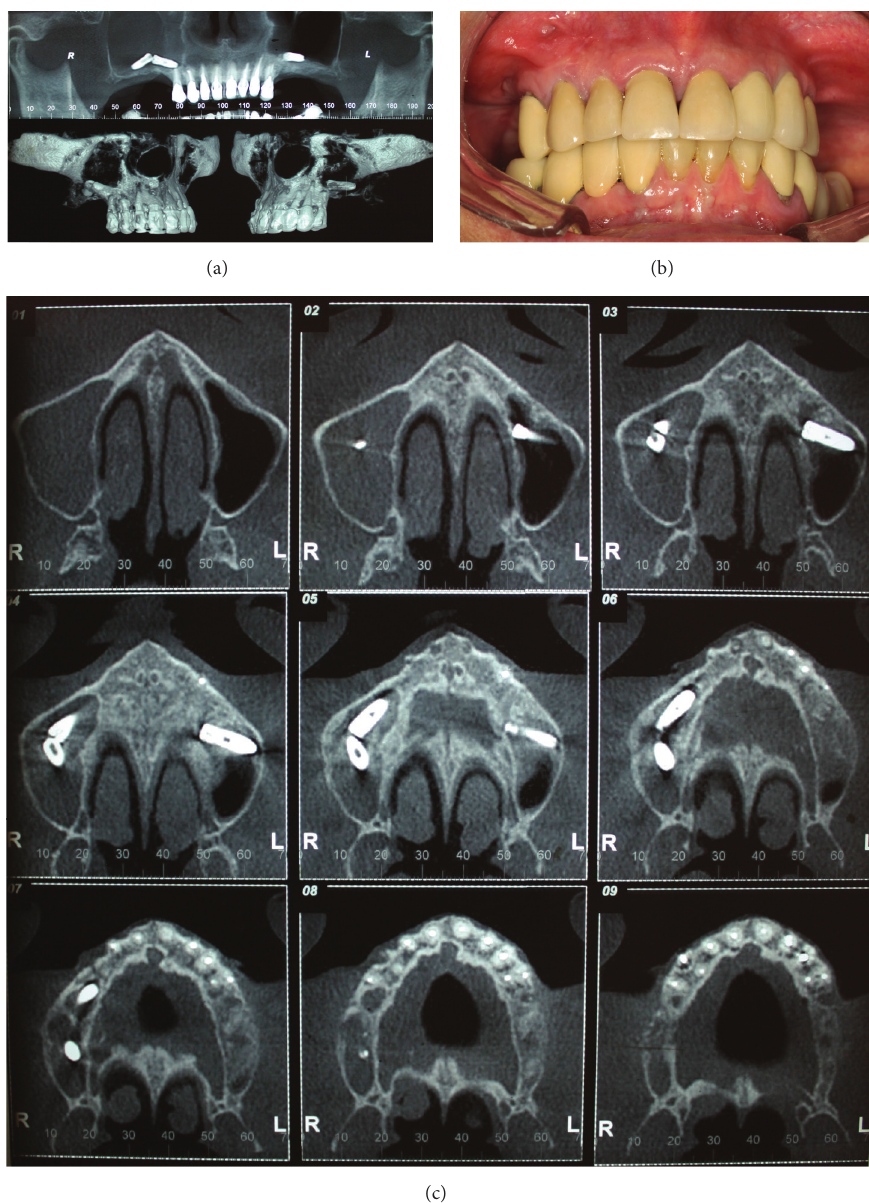
Figure 1: (a) A panoramic and a tridimensional reconstruction CT scan showing the implants displaced into the maxillary sinus cavity with a significant opacification of the right maxillary sinus; however, the left sinus does not present the opacification. (b) Photography showing the frontal clinical view. (c) A CT scan in axial sections showing implant displacement into the maxillary sinus cavity with a significant opacification of the right maxillary sinus. The left sinus does not present the